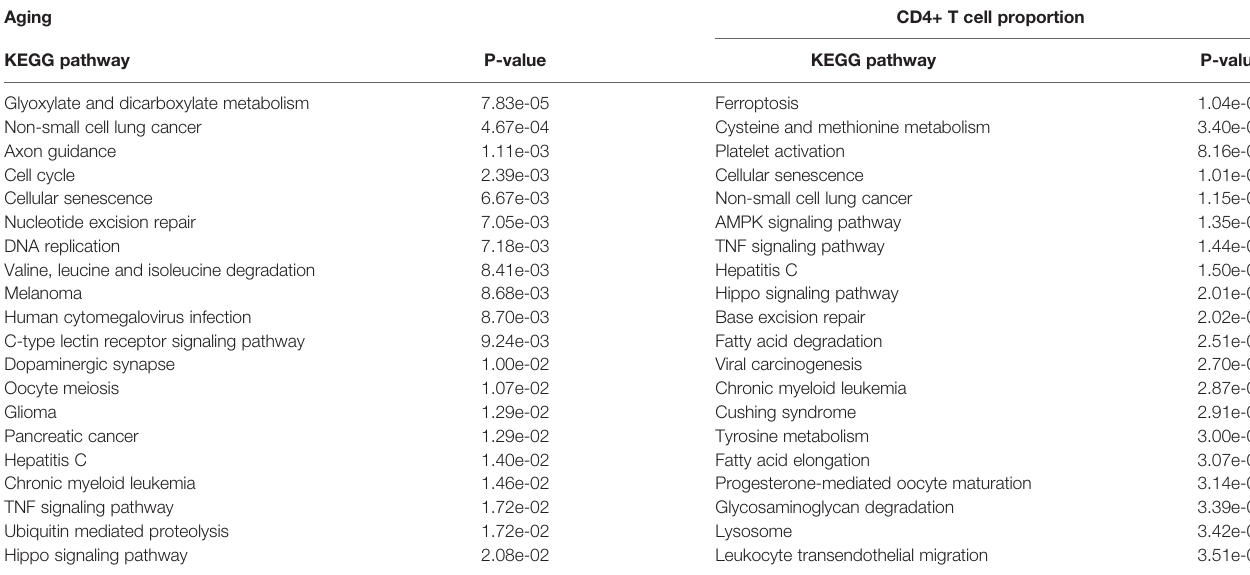
TABLE 1 | The signi fi cantly enriched KEGG pathways of the aging- and CD4+ T cell proportion-derived differential genes (top 20). Aging